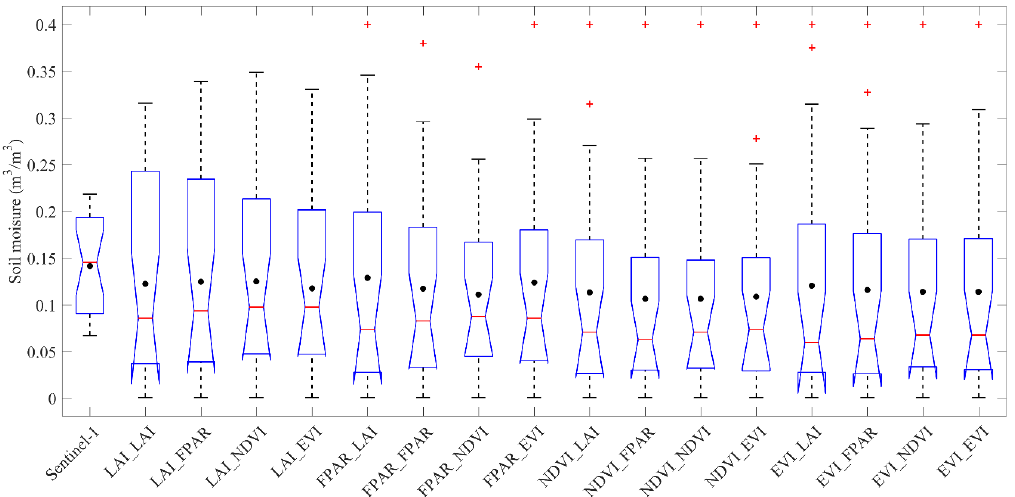
Figure 7. Soil moisture estimated from the coupled model with the different vegetation combinations. The boxplots show the median (red horizontal line), mean (black cycle), 25th and 75th percentiles (top and bottom of the blank box, respectively), and the outlier ranges (edges of the top and bottom whiskers). The “LAI_FPAR” indicates that the V 1 and V 2 are characterized by the LAI and FPAR, respectively.